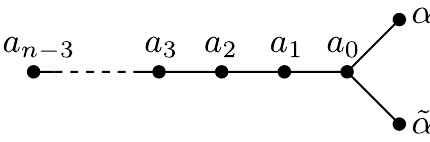
Figure 1. Dynkin diagram for D n